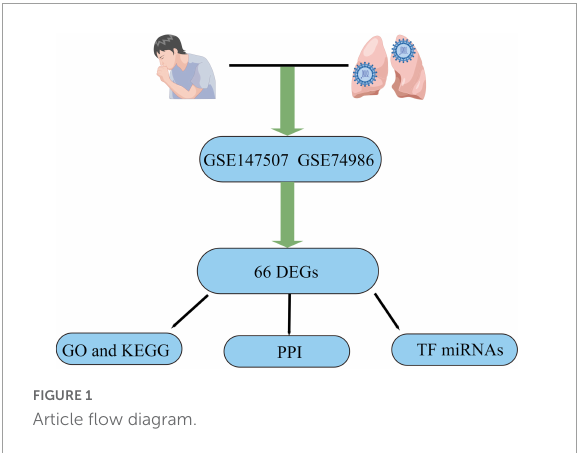
FIGURE1 Article flow